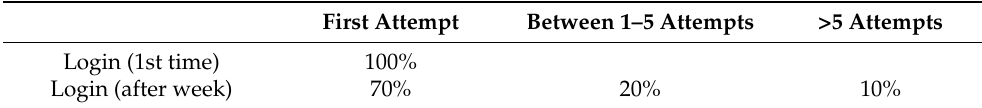
Table 4. Authentication accuracy in two sessions.